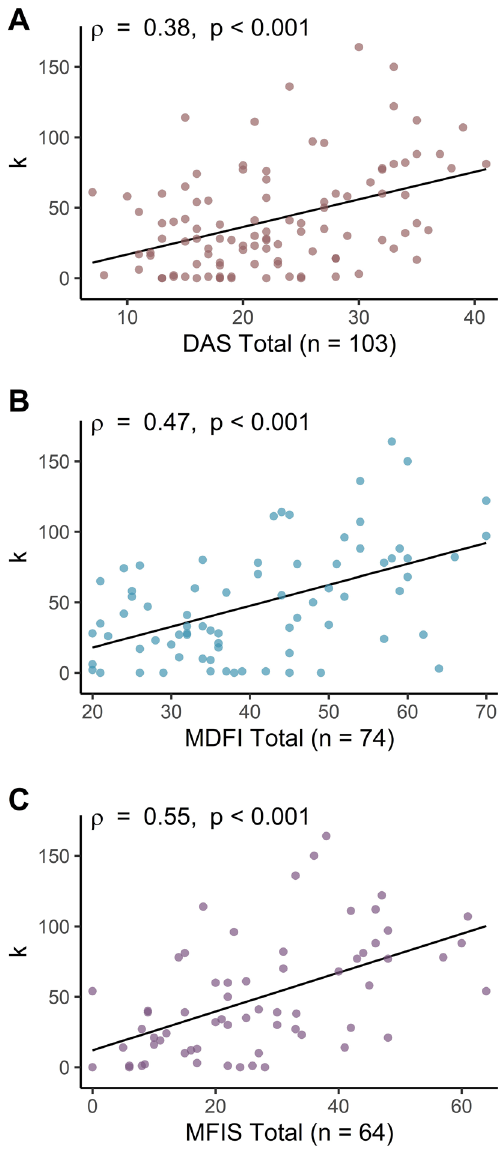
Figure 4. Effort discounting ( k ) was significantly correlated with total scores on the ( A ) DAS, ( B ) MDFI, and ( C )